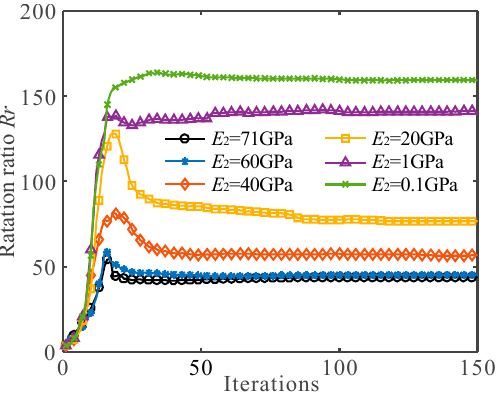
Figure 8. The convergence histories of the rotation ratio R r for different Young’s modulus combina- tions ( E 1 = 71 GPa).